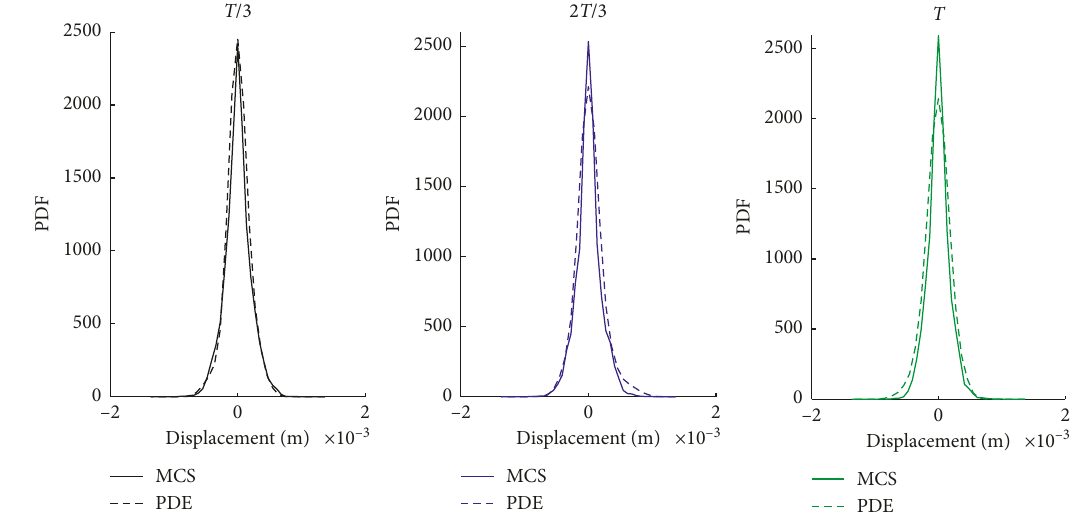
Figure 6: PDFs at different time instances